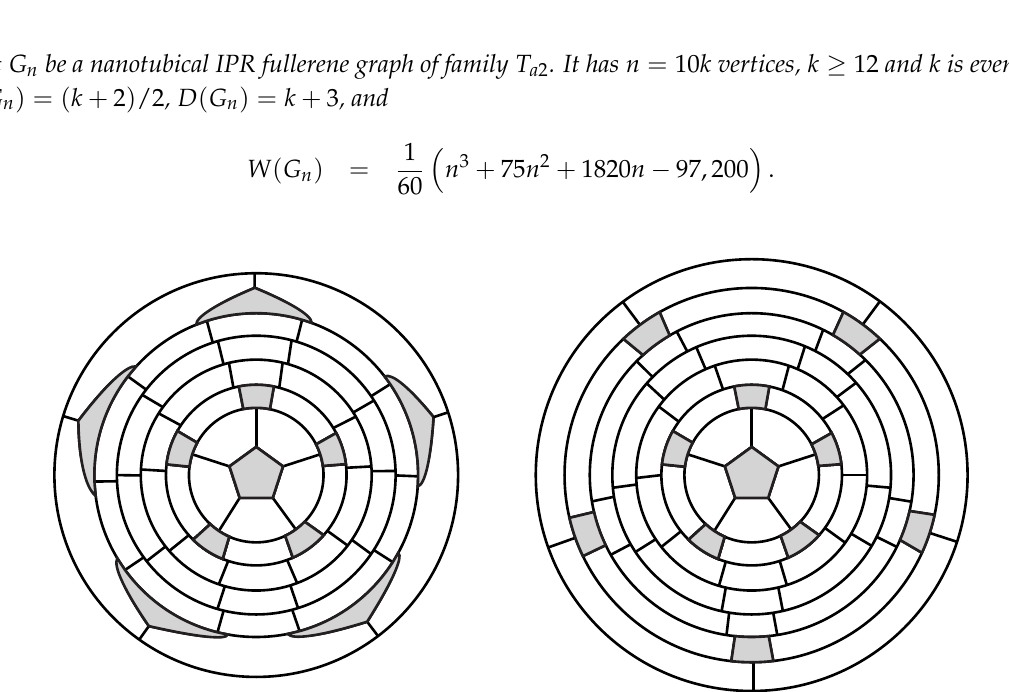
Figure 8. IPR fullerene graphs G 110 ∈ T a 1 ( left ) and G 120 ∈ T a 2 ( right ) with caps of type a